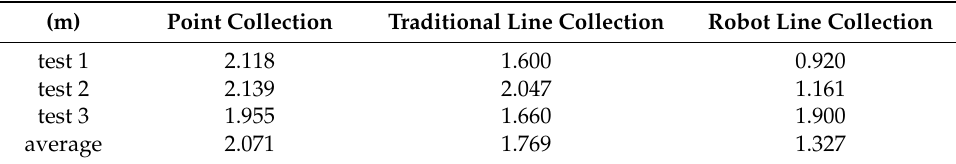
Table 1. Positioning RMSE of three static tests.